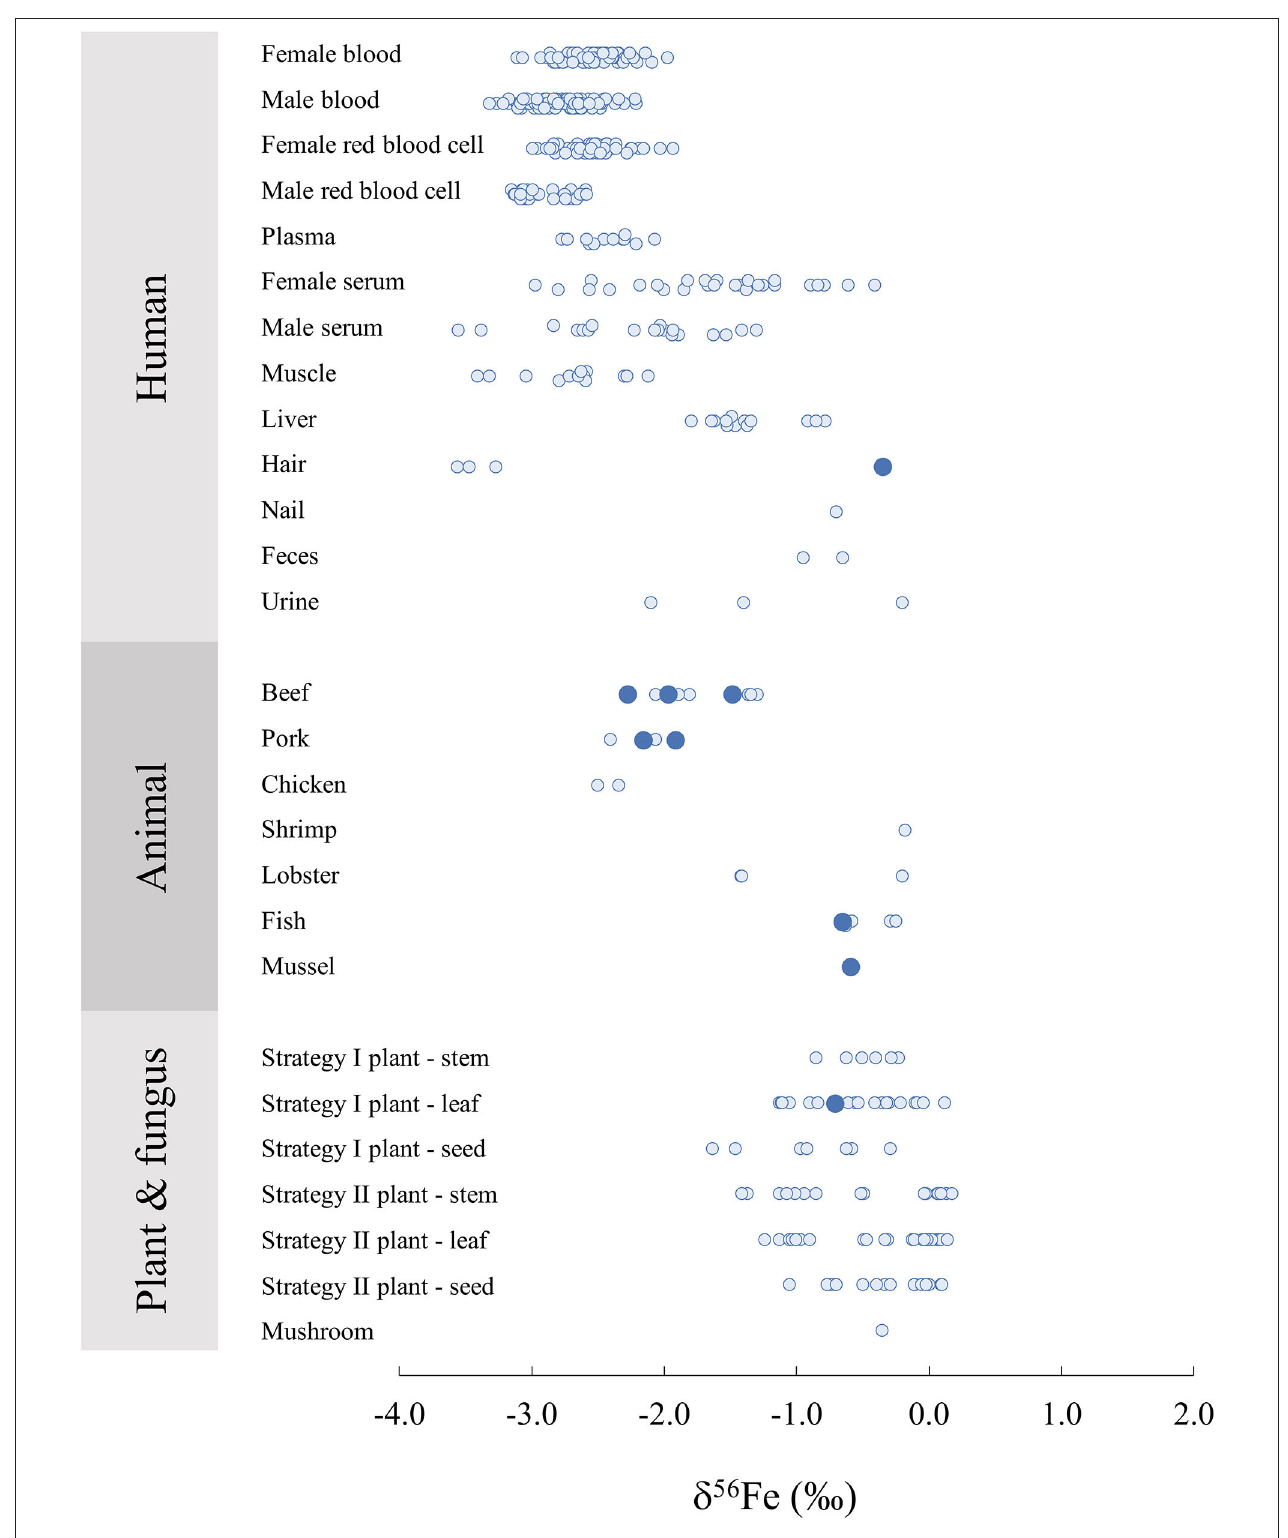
FIGURE 3 | Iron isotope composition δ 56 Fe in biological samples of human, animal, plant and fungus origin from this study (large dark blue circles) and associated literature (20, 27, 34, 36, 44, 48, 51, 52, 56, 59–64).